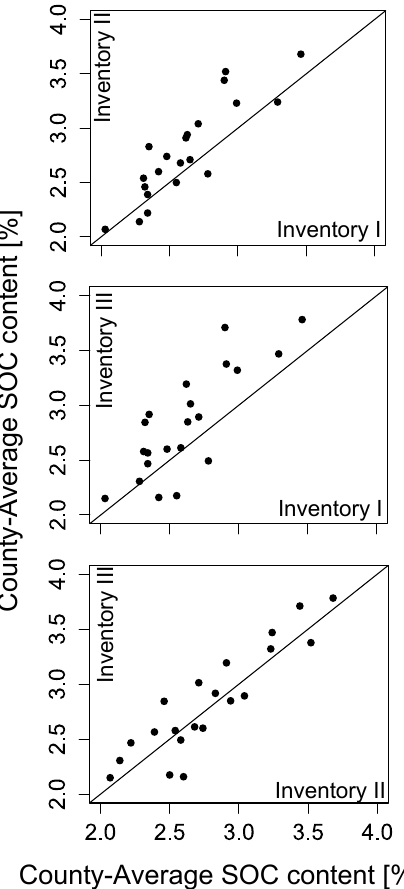
Figure 3. County-average carbon concentrations from Inventories I–III plotted against each other, with 1 : 1 line to visualise shifts in carbon